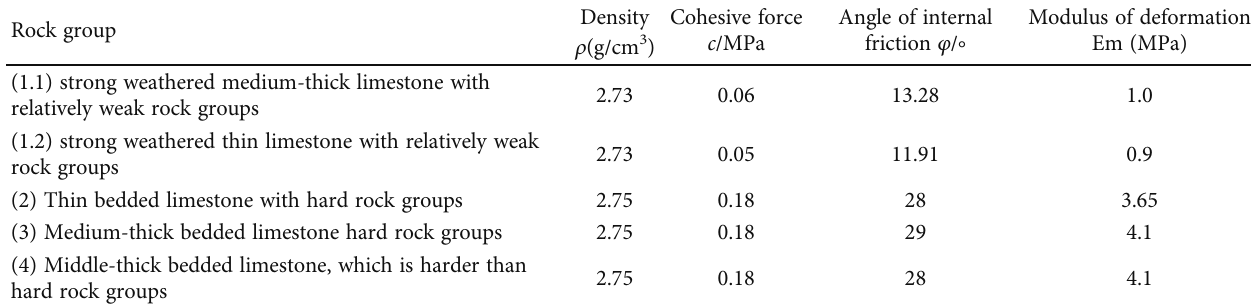
Figure 2: Elevation diagram of slope in the study area. Table 1: Shear strength index of the rock mass.